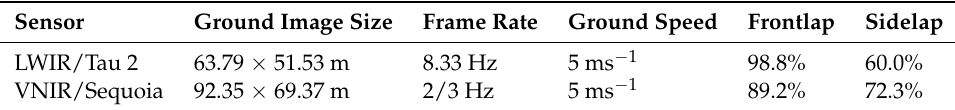
Table A1. Details on the forward and side overlap in the captured imagery at the corresponding altitude of 77